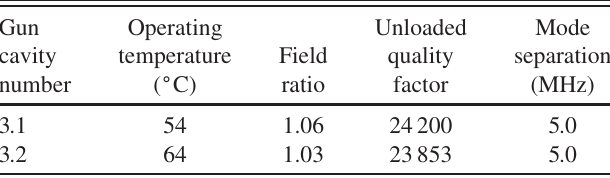
TABLE I. The rf measurement results of two gun cavities. Field ratio refers to the field at the cathode in comparison to the full cell, and the mode separation is the frequency difference between the 0 and the (cid:2) modes.